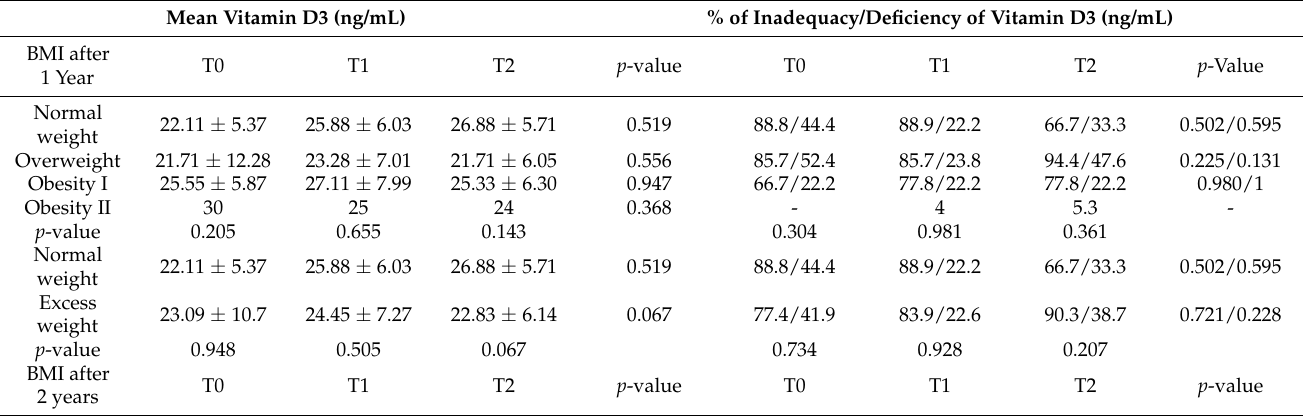
Table 4. Mean serum concentrations and percentage of inadequacy of vitamin D3, calcium and PTH, according to body mass index 1 and 2 years after Roux-en-Y gastric